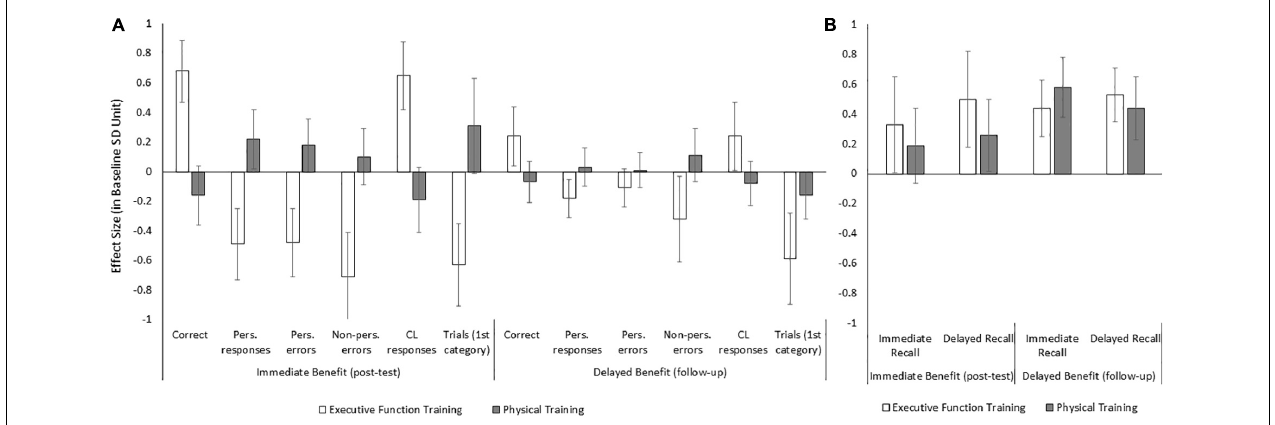
FIGURE 1 | The effect size scores of immediate benefit at the post-test session and delayed benefit at the follow-up session in WCST-64 (A) and HVLT-R (B) outcome variables for the executive function and physical training